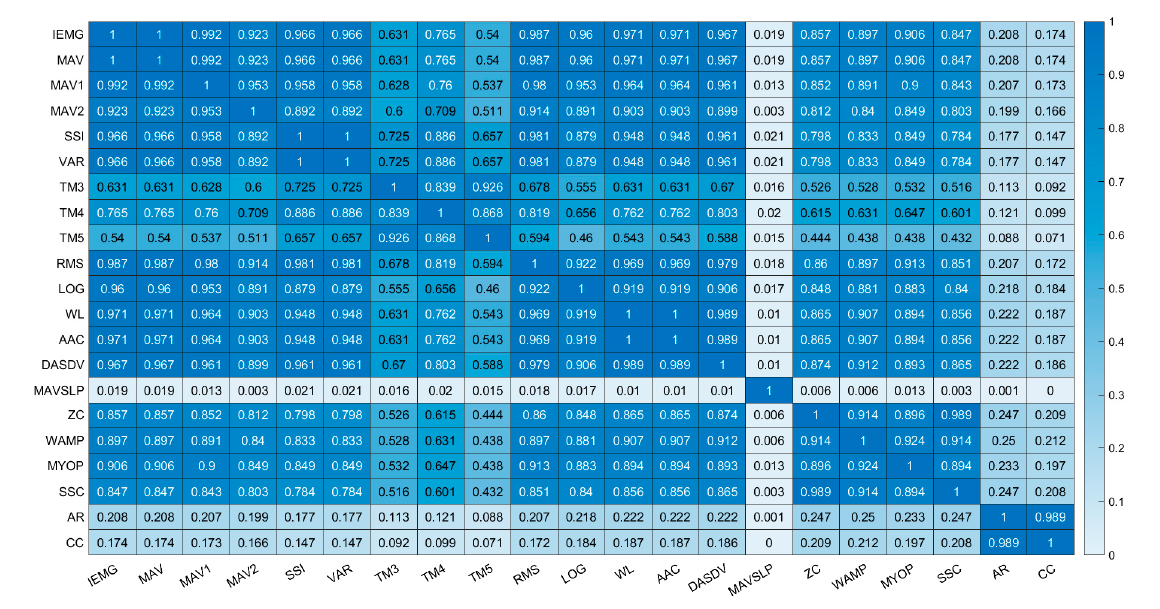
Figure 6. Confusion matrix of inter-feature PCC in Group